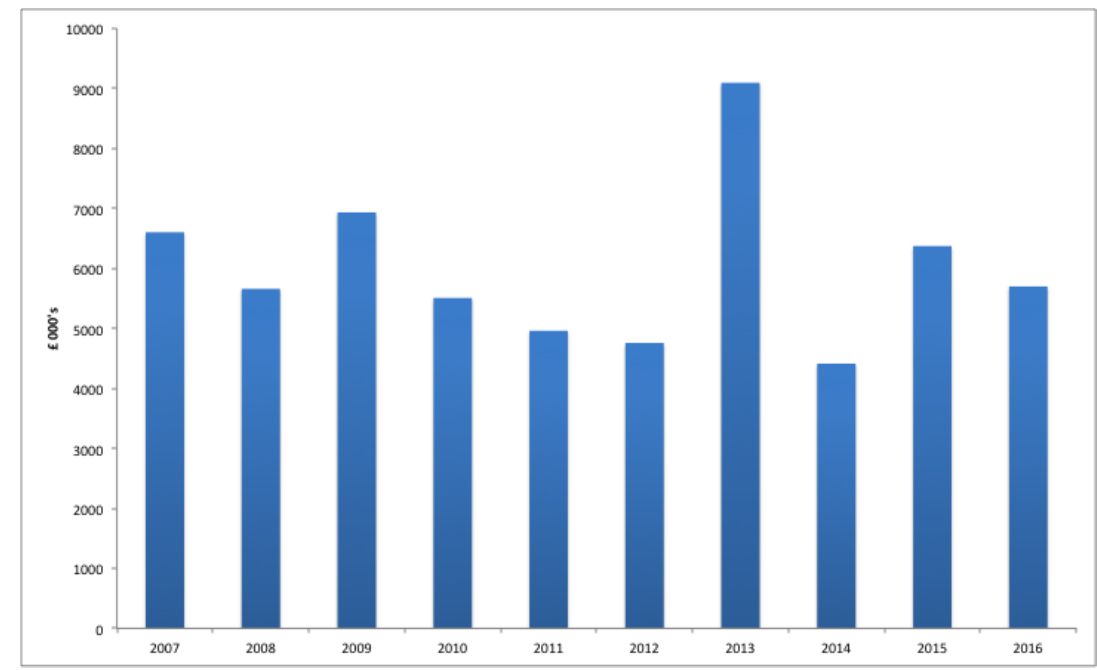
Figure 5. Durham’s annual turnover 2007 – 2016.